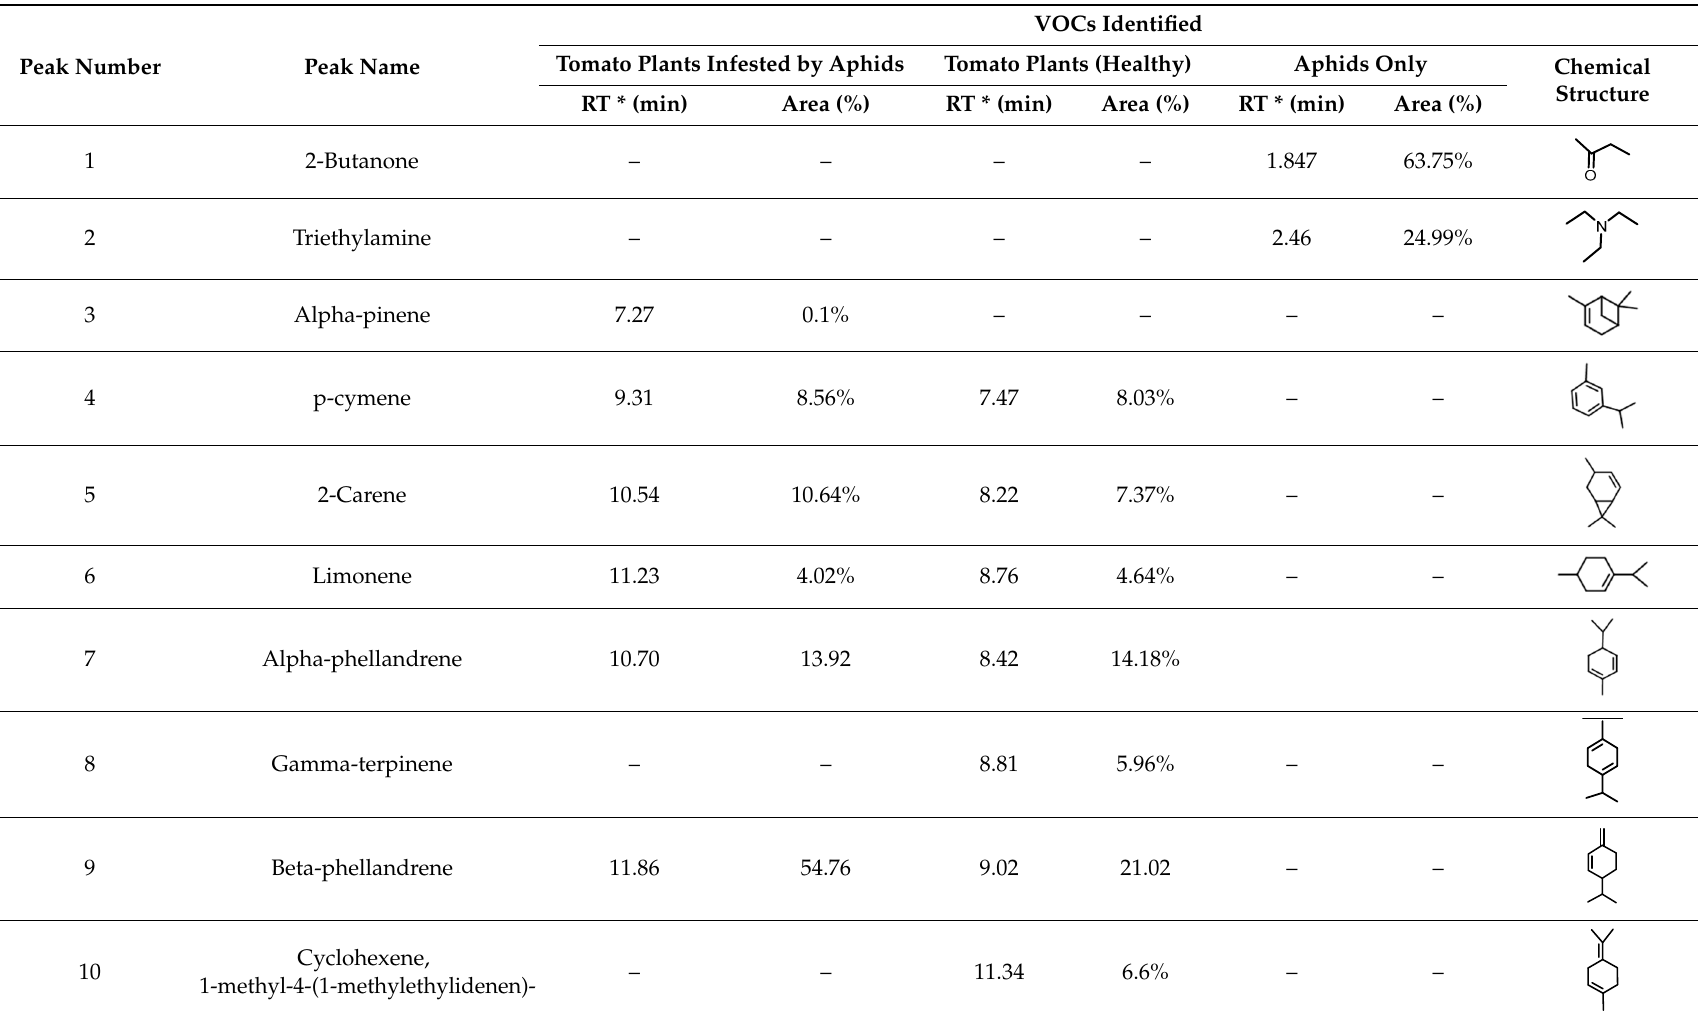
Table 3. Typical VOCs released from aphid-infested tomato plants and healthy ones.